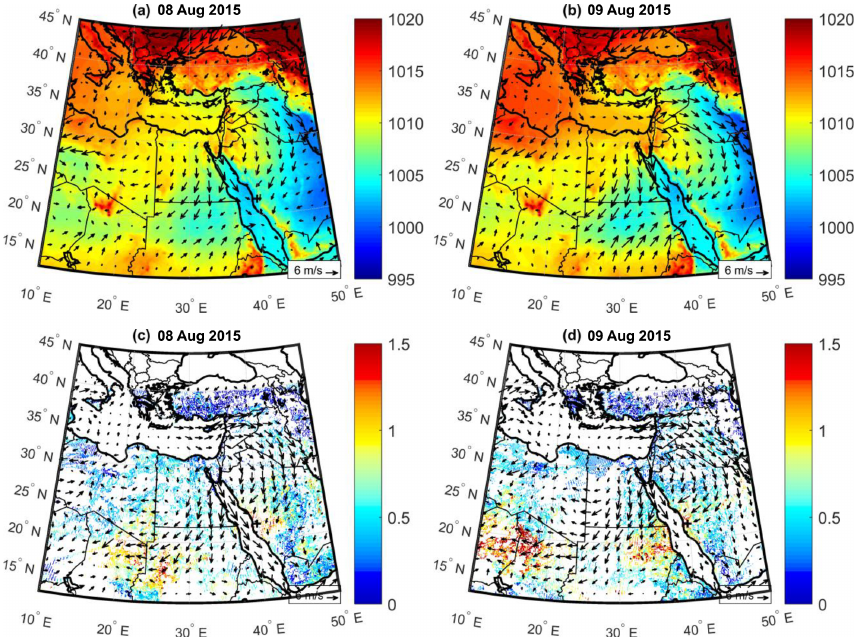
Figure 8. Mean sea level pressure (MSLP) and wind vectors from ECMWF operational analysis data during the dust event (a, b) and MODIS deep blue AOD data overlain by model wind vectors (c, d) . The KAUST site is marked by a + sign.